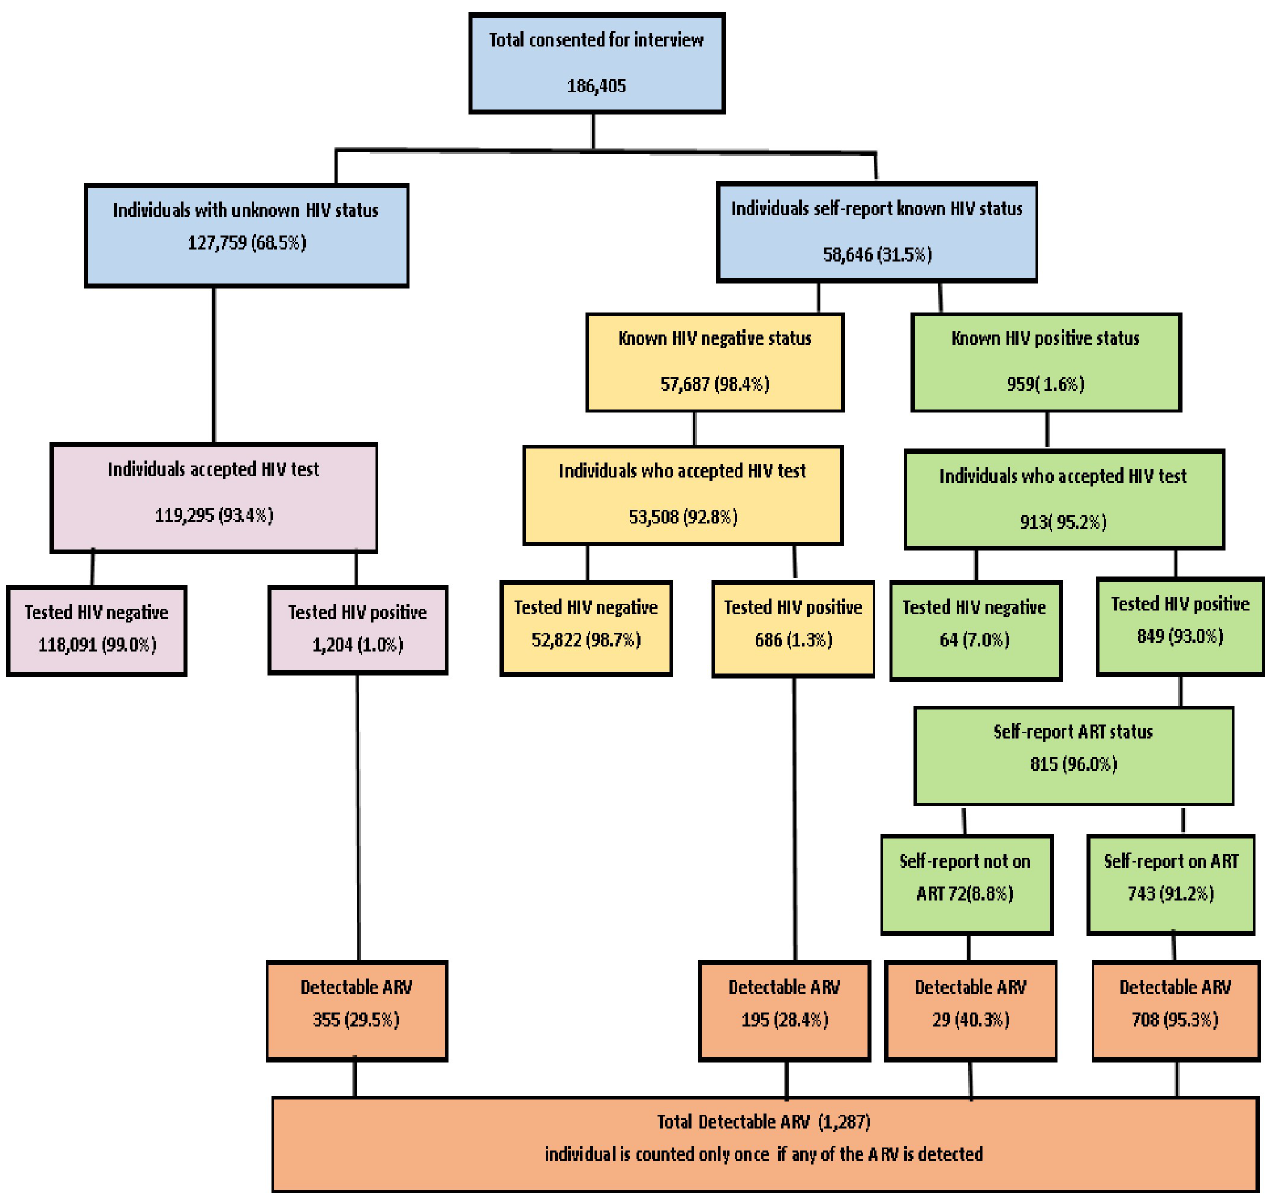
Fig 1. Cascade of self-reported HIV status and self-reported antiretroviral drug (ARV) use among individuals who consented for interview (percentages within the figure are unweighted). (Nigeria HIV/AIDS and Indicator Survey 2018). https://doi.org/10.1371/journal.pone.0273748.g001 tested HIV-positive via RDT, and ARV biomarkers were detected among 195 (25.1%). Overall, the HIV-positivity rate among participants who self-reported known HIV positive or negative status increased from 1.6% to 2.6% after HIV self-report status was confirmed with RDT. Of those who tested HIV-positive, 96.0% self-reported their ARV use status:743 (89.8%) reported using ARV, and 72 (10.2%) reported not using ARV. ARV drugs were detected among 94.5% of those who self-reported using ARV and among 42.0% of those who self-reported not using ARV. However, ARV were not detected among 5.5% of individuals who self-reported using ARV.